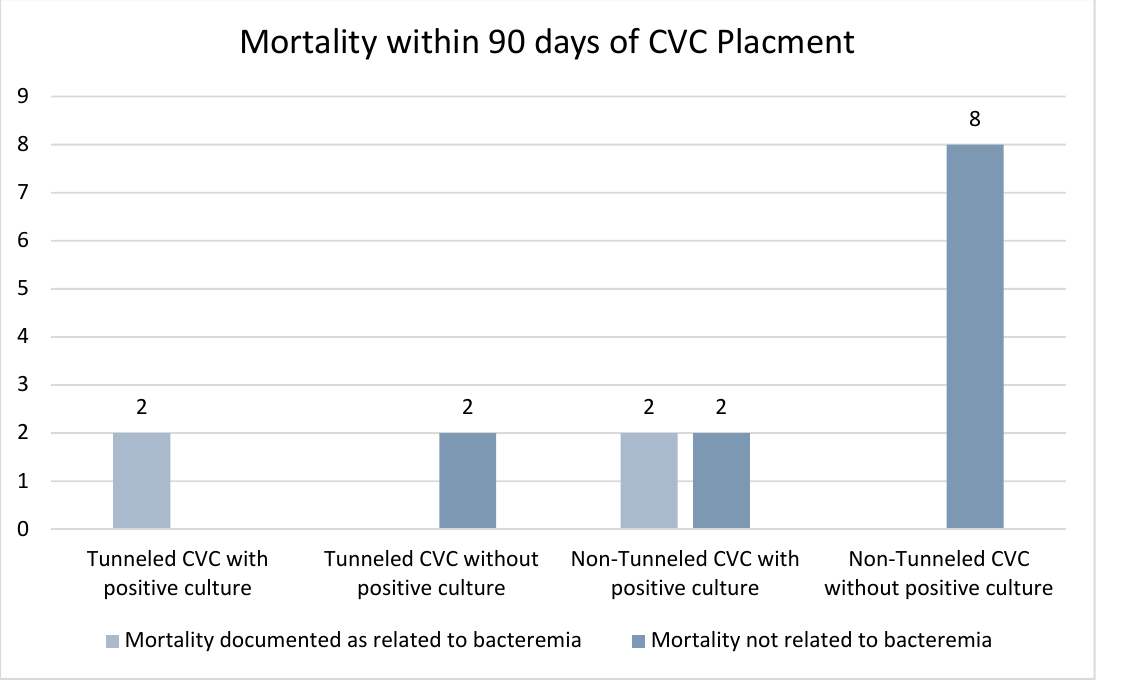
Figure 2. Mortality rate of patients deceased within 90 days of line placement.